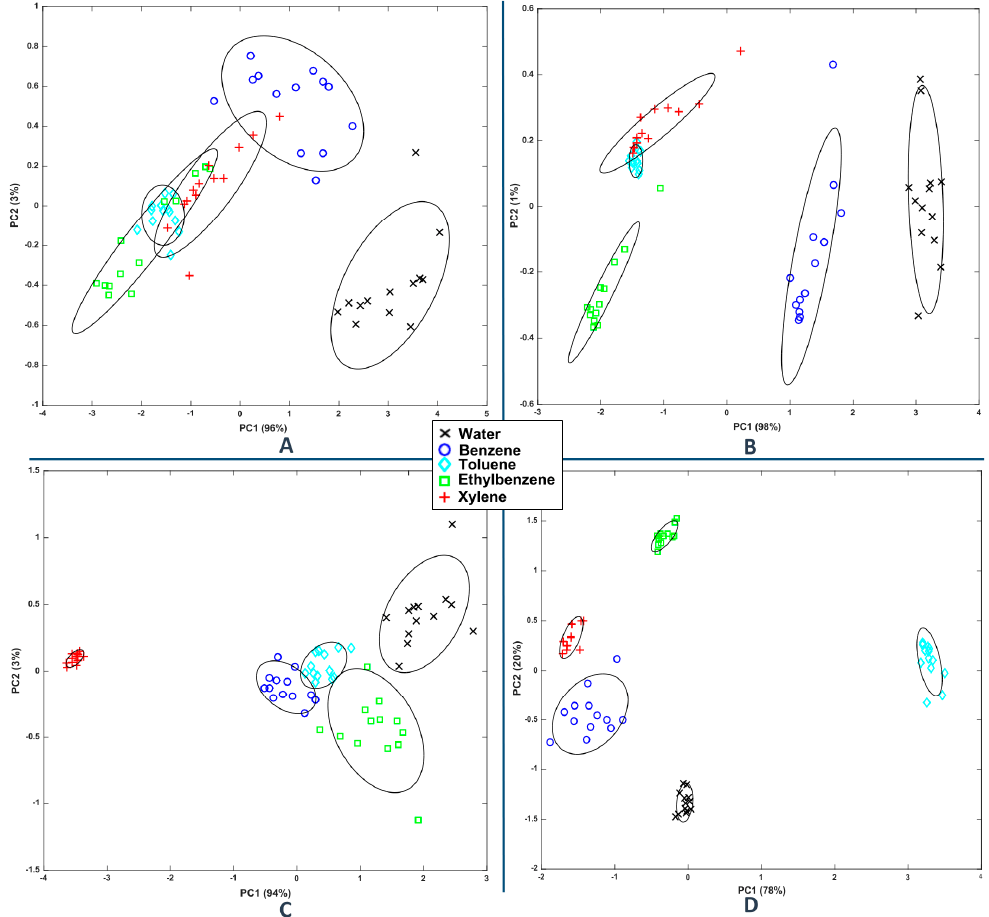
Figure 12. Principal component analysis (PCA) plot for benzene, toluene, ethylbenzene, and xylene (BTEX) compounds of the different datasets: ( A ) PV2; ( B ) PV3 (test 1); ( C ) PV3 (test 2); ( D ) PV4.